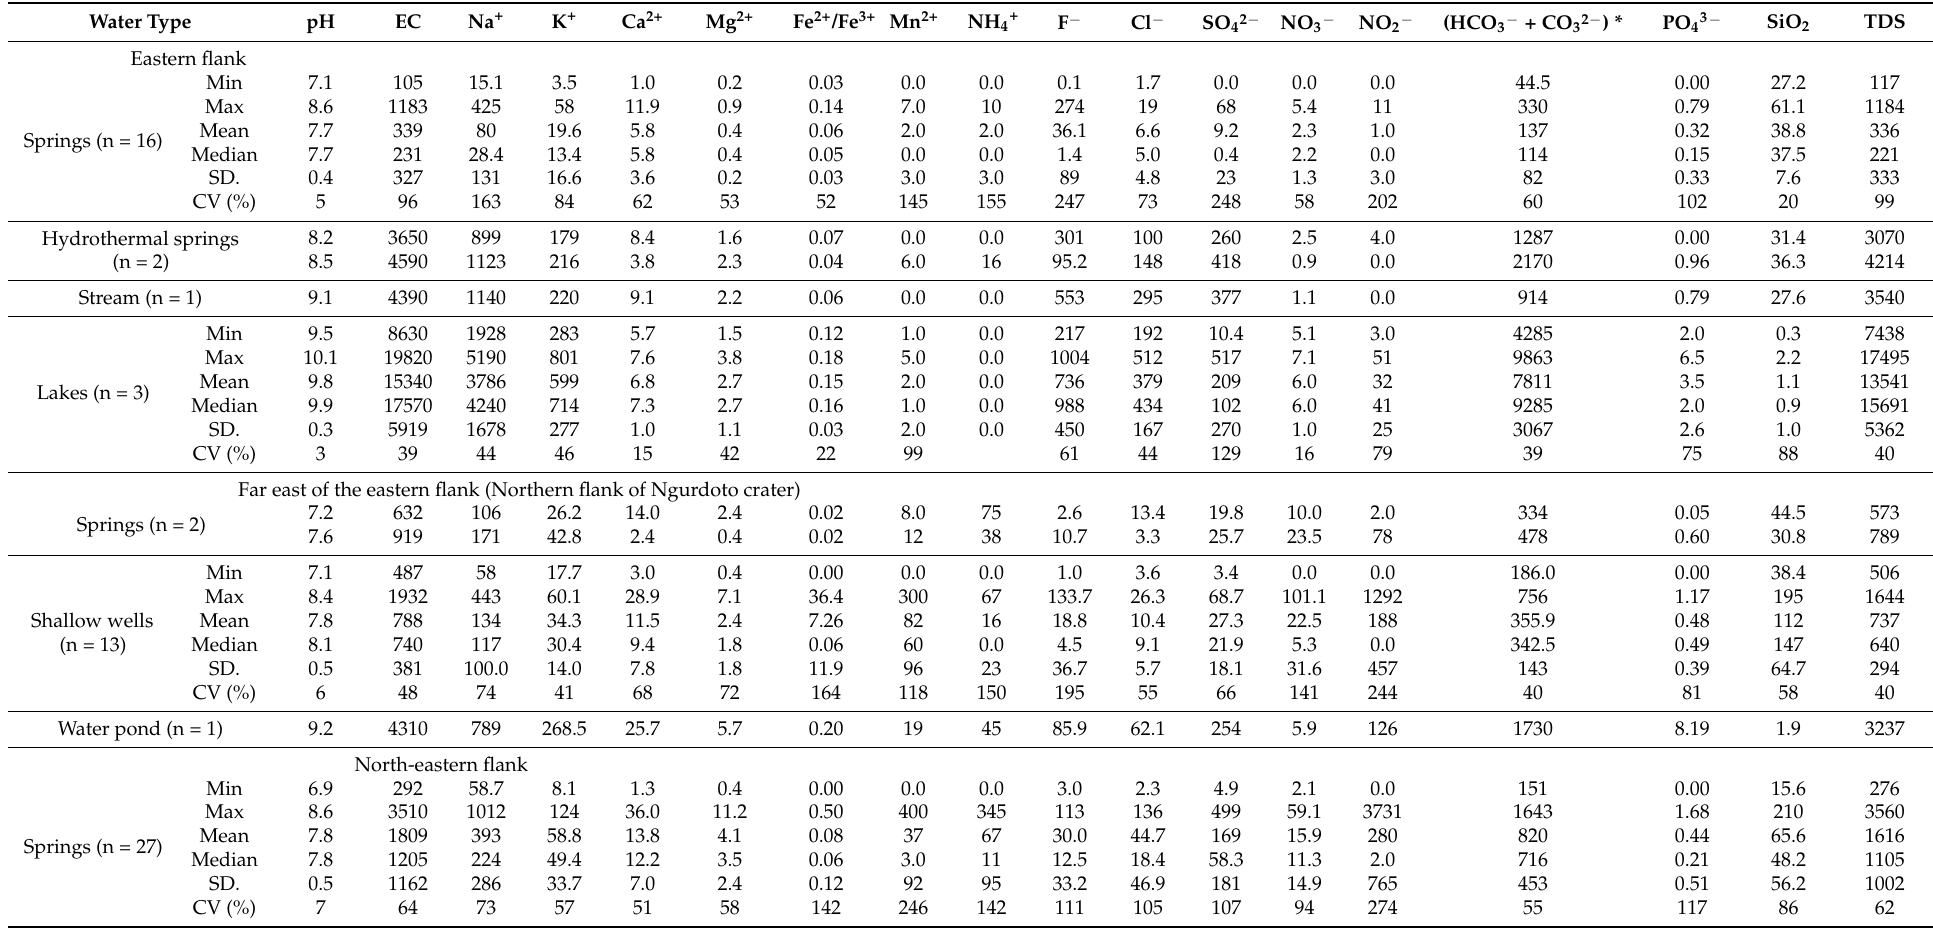
Table 2. Summary of descriptive statistics for major and minor physicochemical parameters of water samples (units are in mg/L for the ions, except for Mn 2+ , NH 4+ , and NO 2 − which are in µ g/L, the pH is unitless and EC is in µ S/cm at 25 ◦ C. n: number of samples; SD: standard deviation; CV: coefficient of variation; * as mg/L HCO 3 − ). Water Type